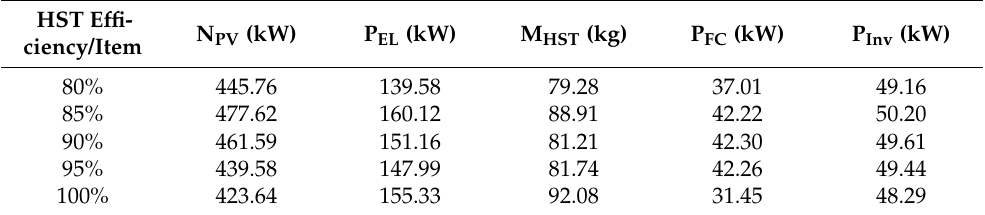
Table 10. Sizing results of an HPV/FC energy system using the IAEO and ENSP max = 5% considering different HST efficiency values.